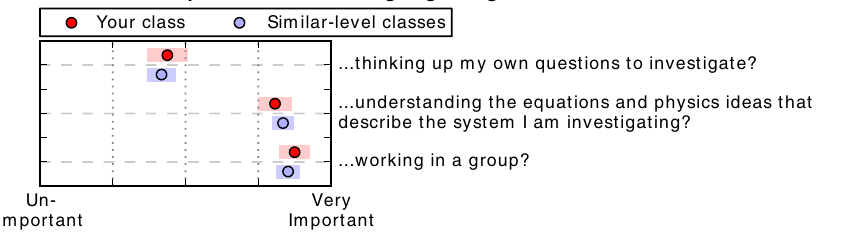
FIG. 6. Students ’ views of the importance of different activities for earning a good grade in your class (red) and in similar-level classes (i.e., introductory calculus-based physics classes) (blue). The data shown are for a subset of 3 out of 23